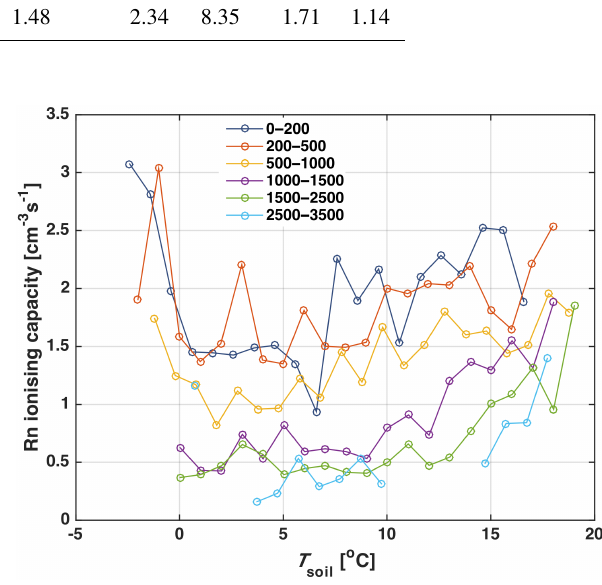
Figure 5. The median radon ionising capacity as a function of the soil temperature in 1 ◦ C bins. Lines are colour-coded by mixing layer height (MLH)